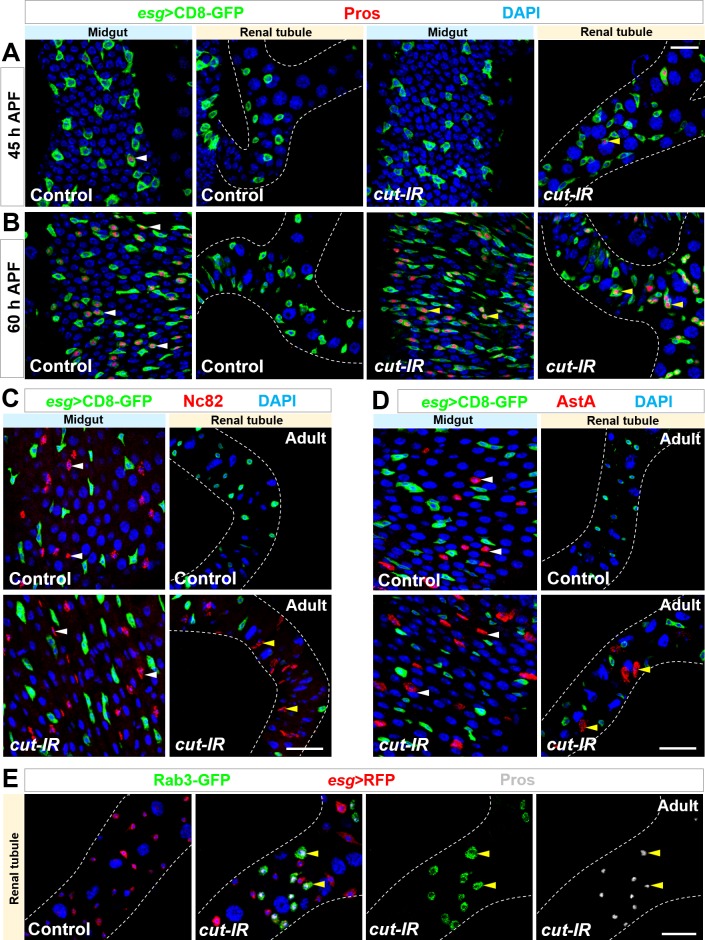
Cut-depleted Esg+ progenitors in renal tubules behave exactly like midgut progenitors.(A,B) Time-course analysis of EE production in renal tubules of esgts > cut RNAi flies. (A) At 45 hr APF, Pros+ EEs (white arrowheads) start to appear in wild type control midgut but not renal tubules. Pros+ EEs (yellow arrowheads) also start to emerge in esgts > cut RNAi renal tubules. (B) At 60 hr APF, around half of Esg+ cells in wild type control midgut (white arrowheads) or esgts > cut RNAi renal tubules (yellow arrowheads) are Pros+ EEs. (C–E) Nc82+ (arrowheads in C), AstA+ (arrowheads in D) or Rab3-GFP+ Pros+ (arrowheads in E) EEs form in esgts > cut RNAi but not in WT control renal tubules. Note that Nc82 is the antigen of EE marker Brp. Scale bars, 20 μm (A,B) and 25 μm (C–E).